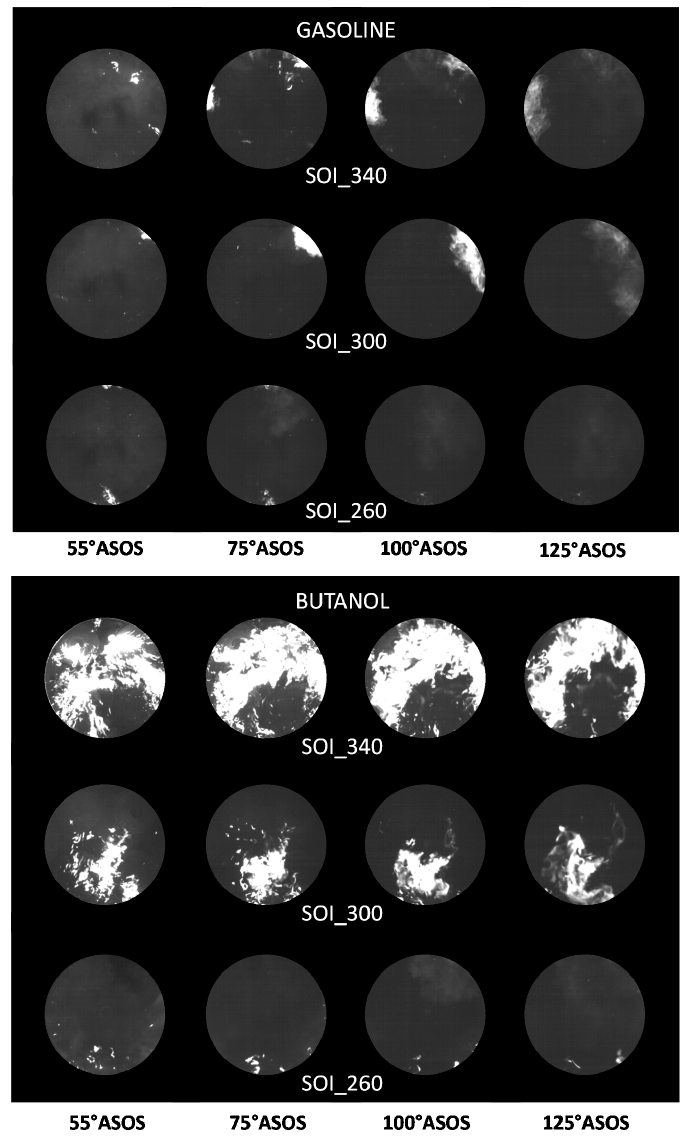
Figure 11. Images recorded at different instances during the intake stroke, representative for the size and location of the diffusive flames. and location of the diffusive